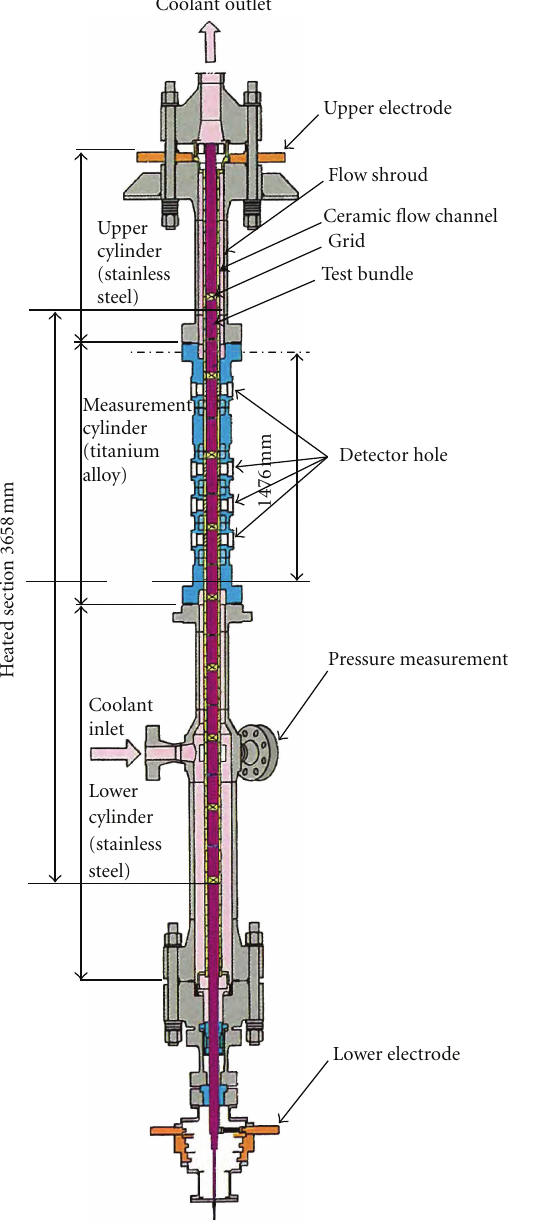
Figure 7: PSBT test vessel and flow channel structures.